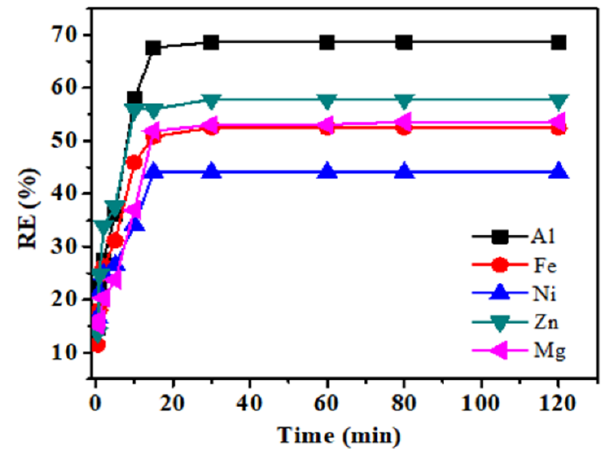
Figure 2. Effect of resin dosage on the ion exchange of Al(III),Fe(II), Zn(II), Mg(II) and Ni(II) using the AmberliteIR-120 (temperature: 318 K; stirring speed: 150 rpm; contact time, 15 min).